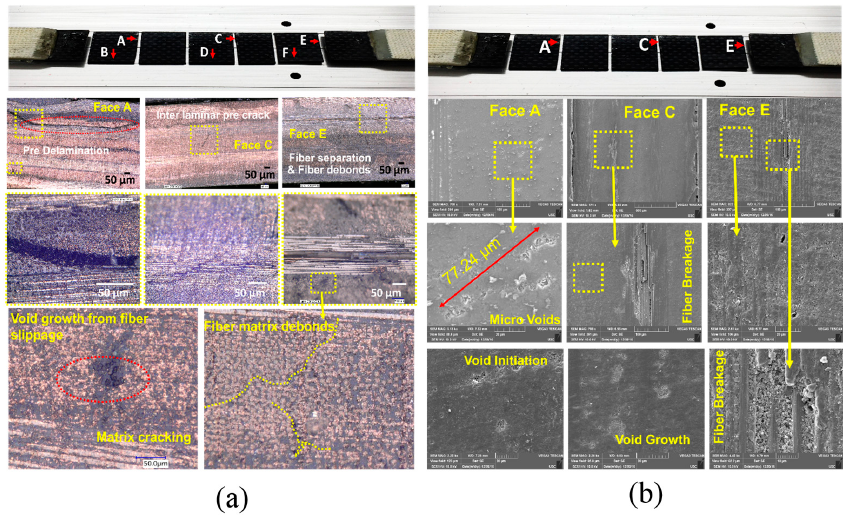
Figure 7. ( a ) Optical microscopy images of the decommissioned specimen S-A at the end of 300,000 cycles; ( b ) Scanning Electron Microscopy (SEM) images from the decommissioned specimen S-A after 300,000 cycles of fatigue loading.